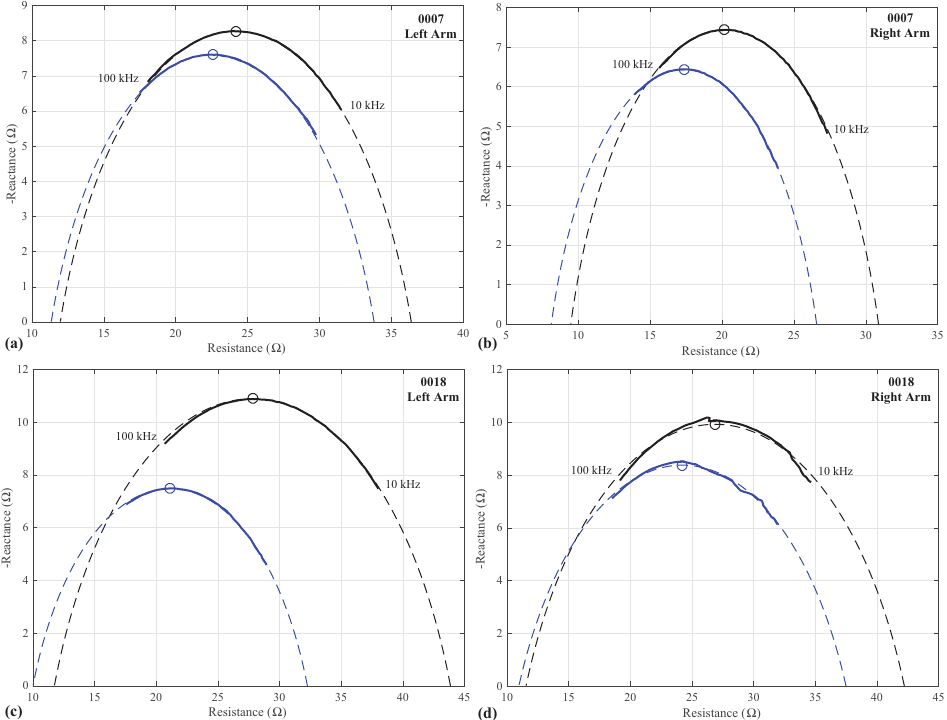
Figure 3. Measured (solid) and simulated using Cole-impedance parameters (dashed) impedance of biceps tissue from ( a ) left and ( b ) right biceps of study participant 0007 and ( c ) left and ( d ) right biceps of study participant 0018. Pre-fatigue measures are presented as black lines with post-fatigue measures presented as blue lines. The peak reactance calculated using the Cole-impedance parameters are presented as a (o) in each